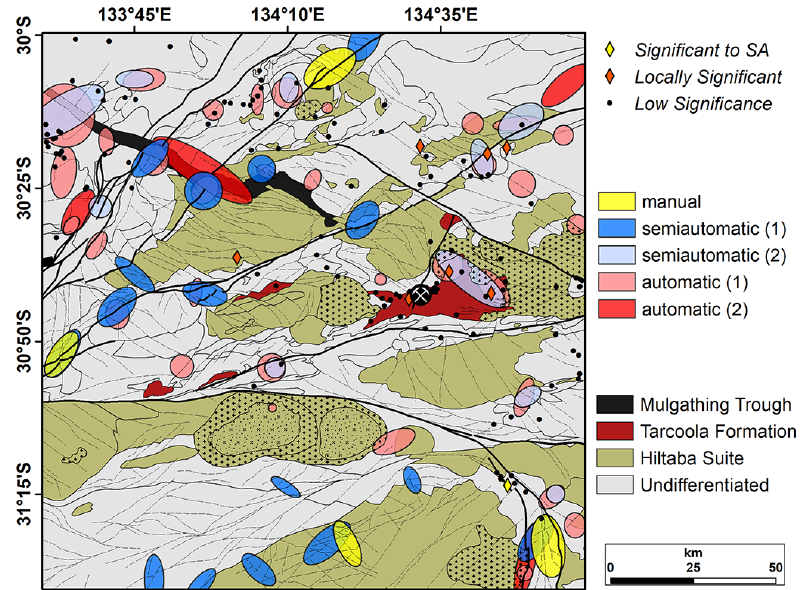
Figure 15. Target areas identified by different combinations of lineament sets displayed on a geological and structural map. In the legend manual refers to datasets that are divided solely through expert interpretation (Fig. 12), semiautomatic represents datasets that are a com- bination of manually interpreted data (Fig. 13), and automatic refers fully automatically extracted lineament data (Fig. 14). Yellow and red diamonds indicate state-wide (SA: South Australia) and locally significant mineral occurrences that were detected in drill cores. The black dots are mineralisations that are below economic significance. The legend for the geological and structural units is shown in Fig.